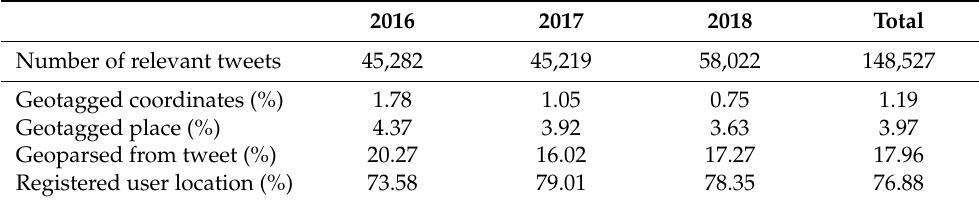
Table 4. The number of tweets classified as relevant by at least one classifier and percentages of these tweets located by each of the location levels over the years 2016–2018, and in